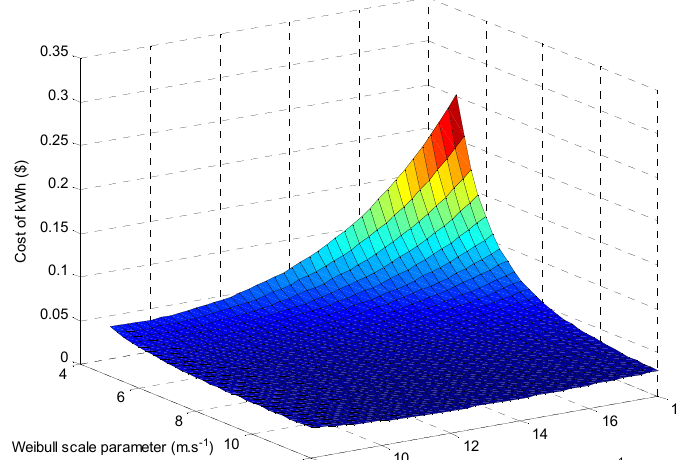
Figure 7. Variation of energy cost for optimized wind turbines with respect to rated wind speed and the Weibull scale